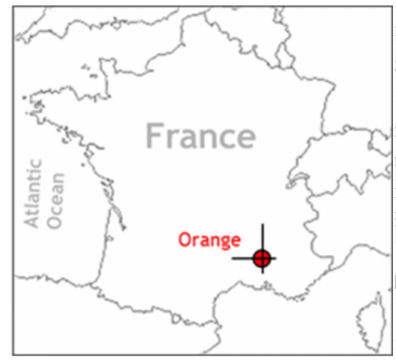
Figure 1. Case study (Orange Station): location